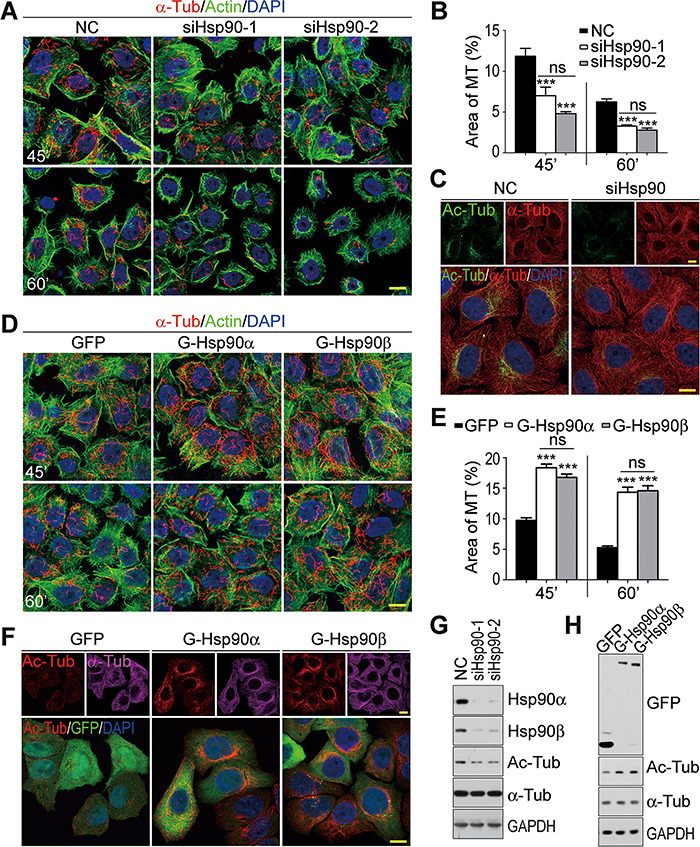
Microtubule destabilization in Hsp90-depleted HeLa cells. (A) Microtubule destabilization induced by Hsp90 depletion. Control (NC) and Hsp90-depleted (siHsp90-1 and siHsp90-2) cells were treated with 2 μM nocodazole for 45 or 60 min (45′ or 60′). After extraction and fixation, the cells were stained for α-Tub to show the remaining microtubules and fluorescent-conjugated phalloidin to mark actin and cell outline. (B) Quantification of the remaining microtubules (MT) in control or Hsp90-depleted cells after nocodazole treatment. The ratio of microtubule area relative to the cell outline area was calculated to measure microtubule stability. The results were the average of three independent experiments, and 35 cells were measured per group for each experiment. Error bars represent SEM. Student’s t-test, ***P < 0.001. (C and G) Decreased microtubule acetylation in Hsp90-depleted HeLa cells. Microtubule acetylation was detected by immunofluorescence (C) and western blot (G). Ac-Tub, acetylated α-tubulin. (D) Microtubule stabilization induced by Hsp90 overexpression. HeLa cells stably expressing GFP or GFP-tagged Hsp90α or Hsp90β were treated with 2 μM nocodazole for 45 or 60 min and stained for microtubule and actin. (E) Quantification of the remaining microtubules after nocodazole treatment in cells overexpressing Hsp90. The results were the average of three independent experiments, and 35 cells were measured for each experiment. Error bars represent SEM. Student’s t-test, ***P < 0.001. (F and H) Increased microtubule acetylation in cells overexpressing Hsp90. Microtubule acetylation was detected by immunofluorescence (F) and western blot (H). Scale bar, 10 μm.